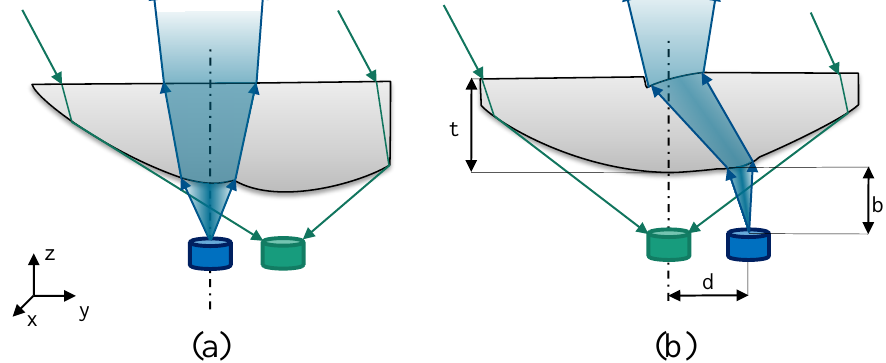
Figure 4. Ray path in the hybrid lens system. ( a ) Center TX (blue) and off-axis RX (green). ( b ) Center RX and off-axis